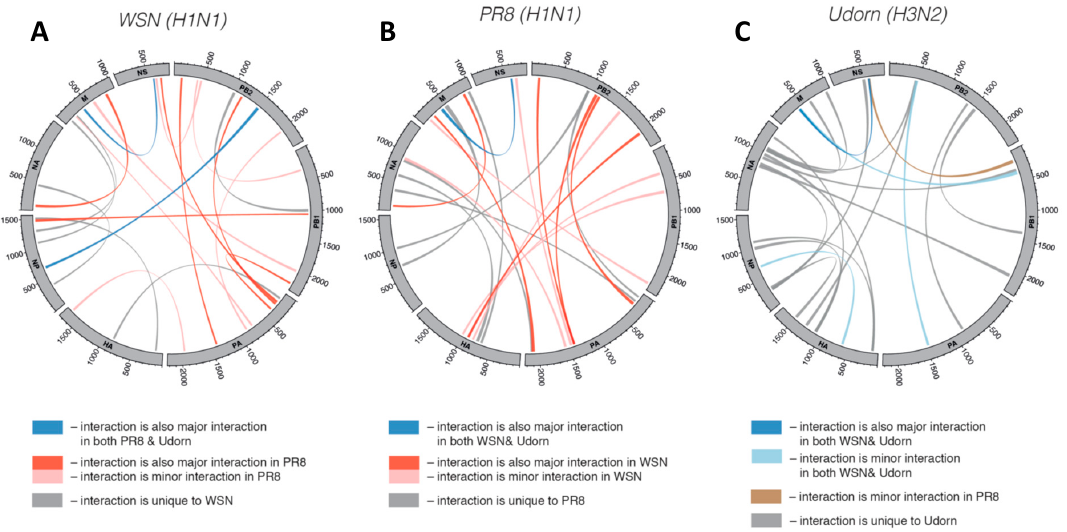
Figure 2. Summary of positions in IAV genome segments involved in inter-segment interactions in different IAV strains [24]. The eight segments are shown aligned in a circle with inter-segment interactions represented by curved coloured lines. See legends for correlations of interactions between IAV strains. (A) WSN (H1N1). (B) PR8 (H1N1). (C) Udorn (H3N2).